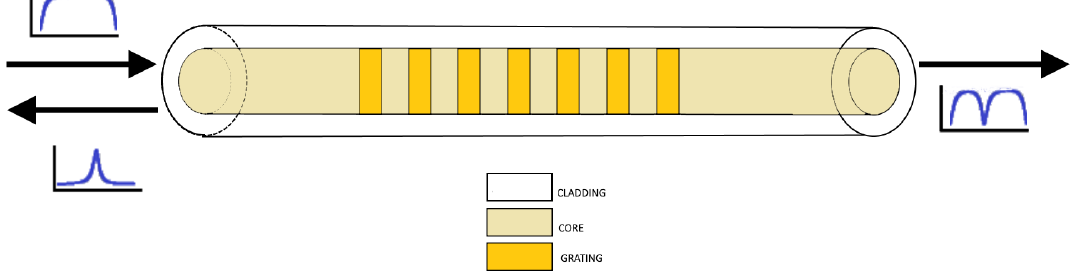
Figure 4. FBG index profile. In insets, the spectrum of the incident, reflected and transmitted beams.